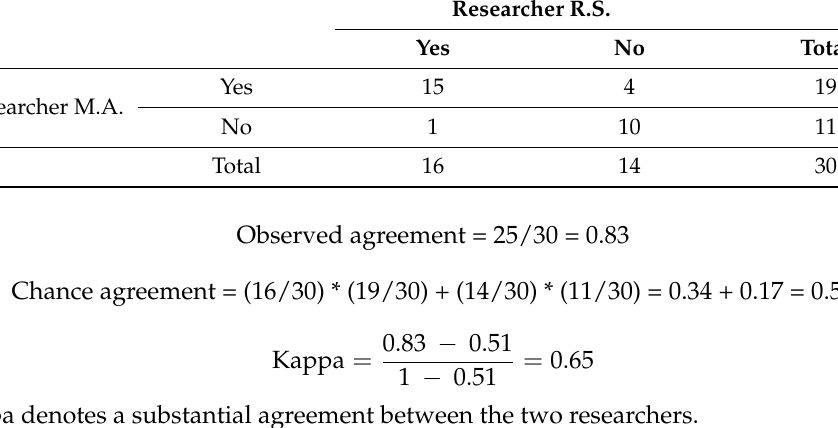
Table 1. Agreement of the two researchers in the full-text review. Researcher M.A.